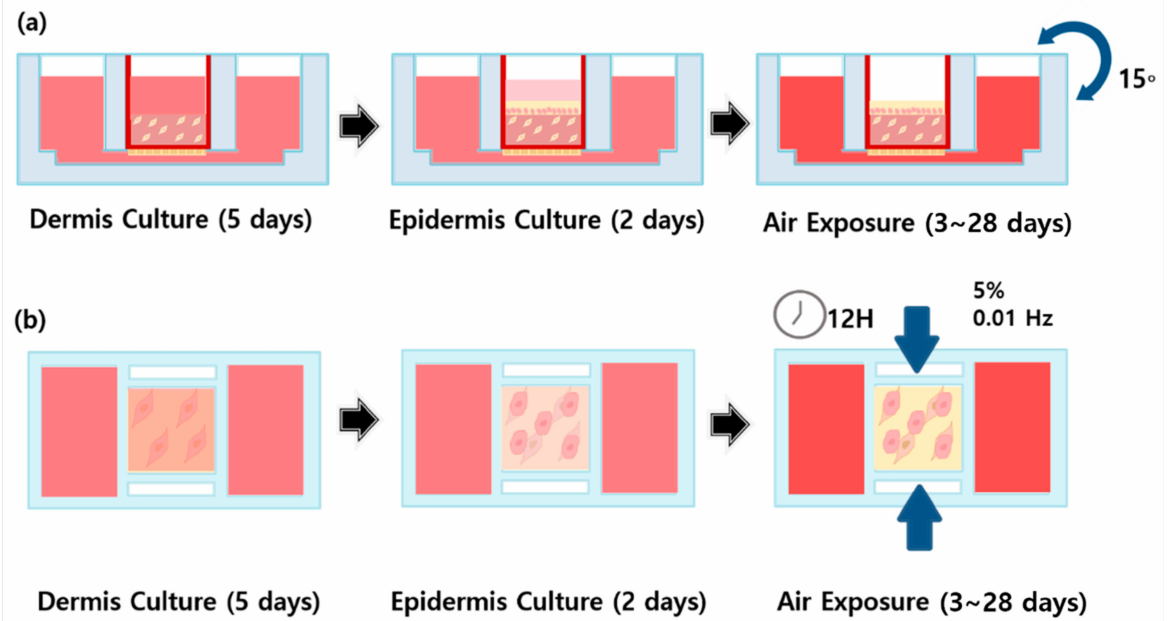
Figure 10. Schematic diagram of ( a ) FSOC 3D culture process using gravity flow system, ( b ) the 3D culture process in which periodic compressive stimulation is applied for 12 h using a mechanical stimulus actuating system (MSAS) and maintained in a non-stimulation state for 12